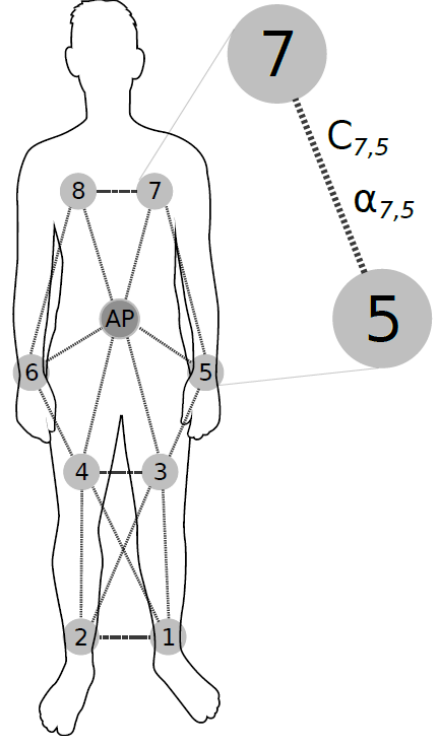
Figure 1. Experimental setup for network architecture with access point on the body. Note that only neighboring nodes network connections are depicted for clarity of